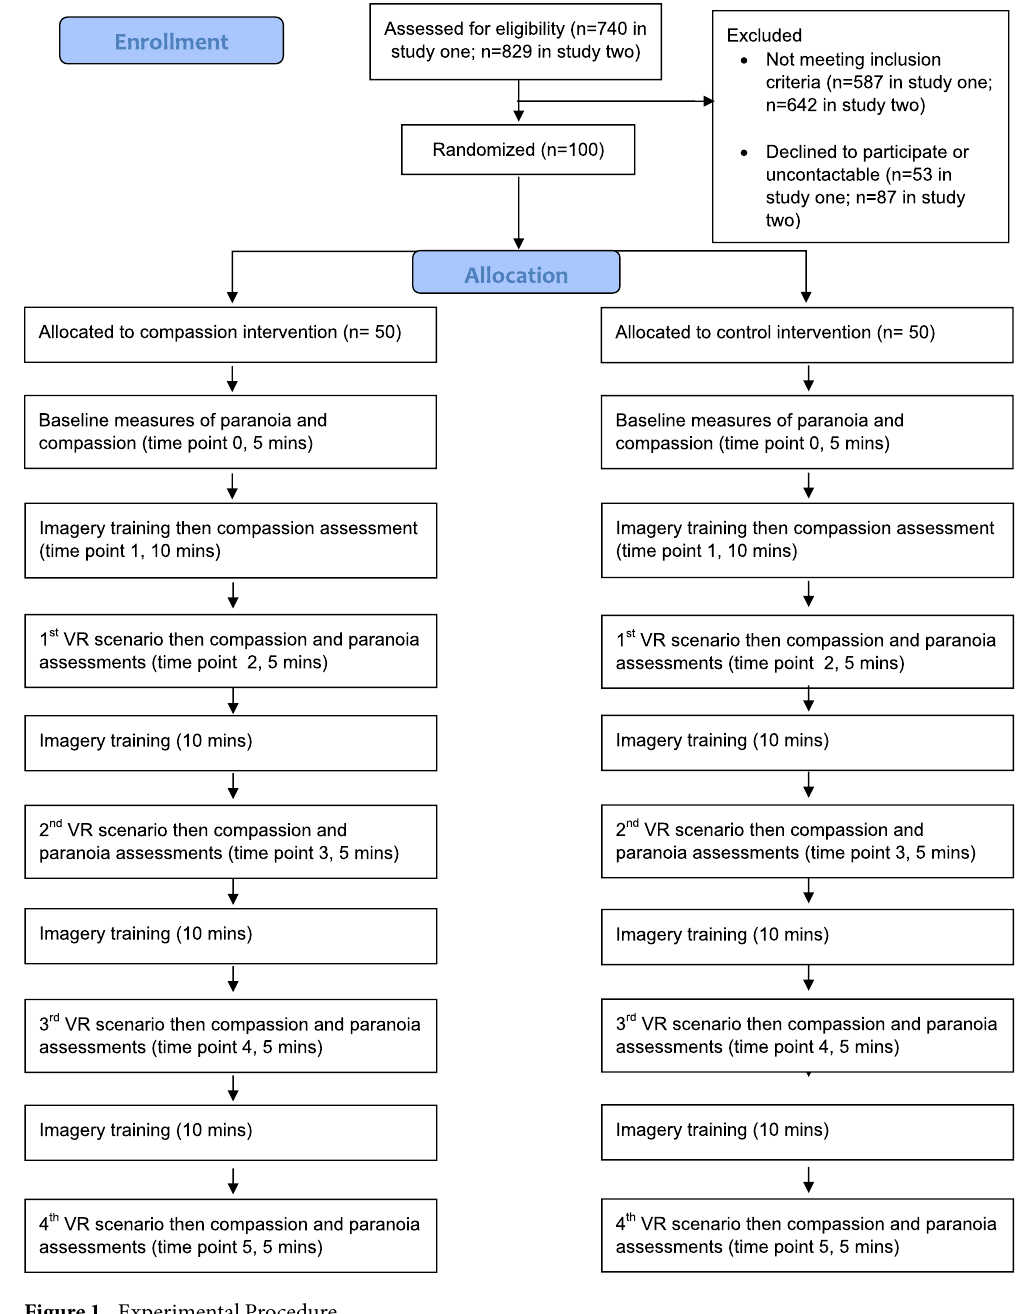
Figure 1. Experimental